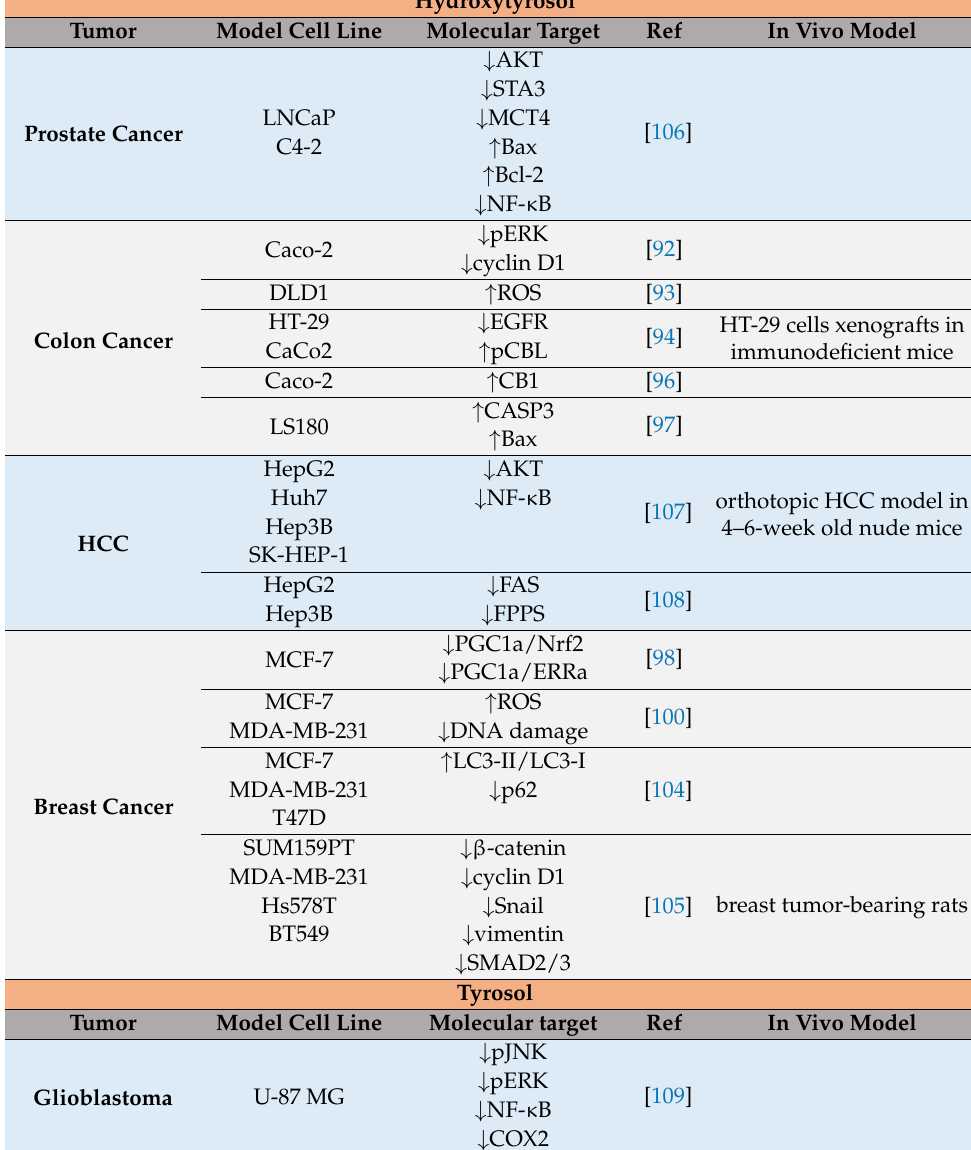
Table 2. Anti-cancer effects of Hydroxytyrosol and Tyrosol: in vitro and in vivo